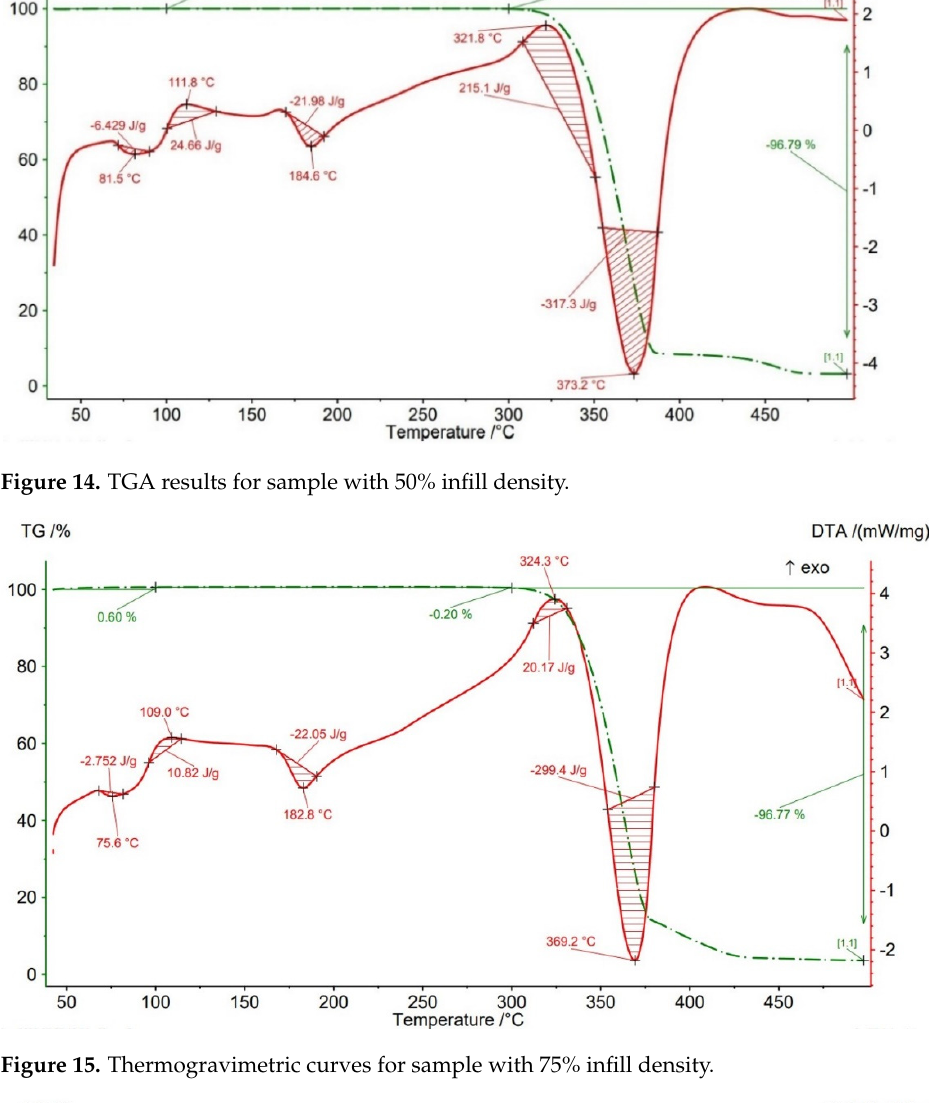
Figure 15. Thermogravimetric curves for sample with 75% infill density.